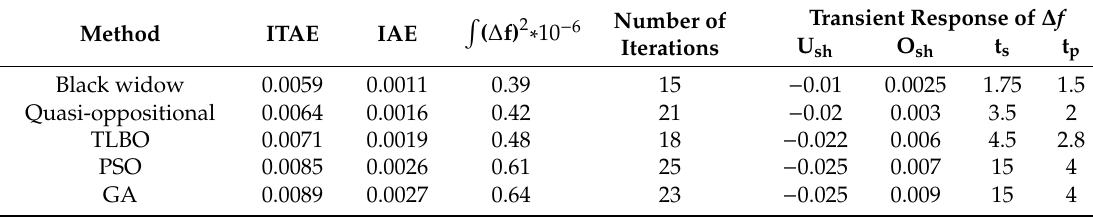
Figure 12. Change in wind power using different optimization techniques. Table 2. Comparison of optimization Table 2. Comparison of optimization methods.